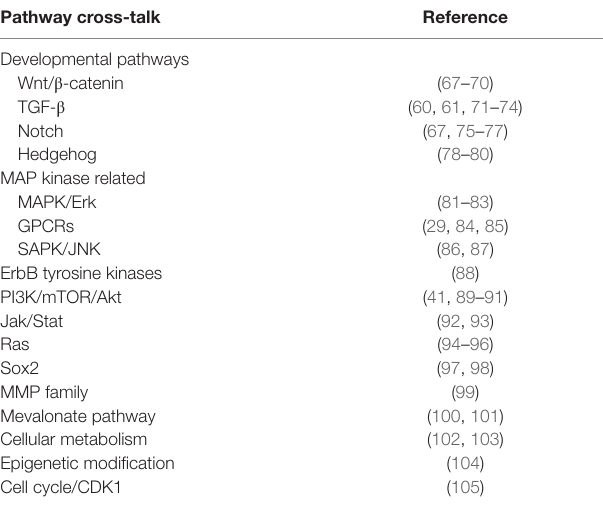
TABLe 1 | Pathway cross-talk with Hippo